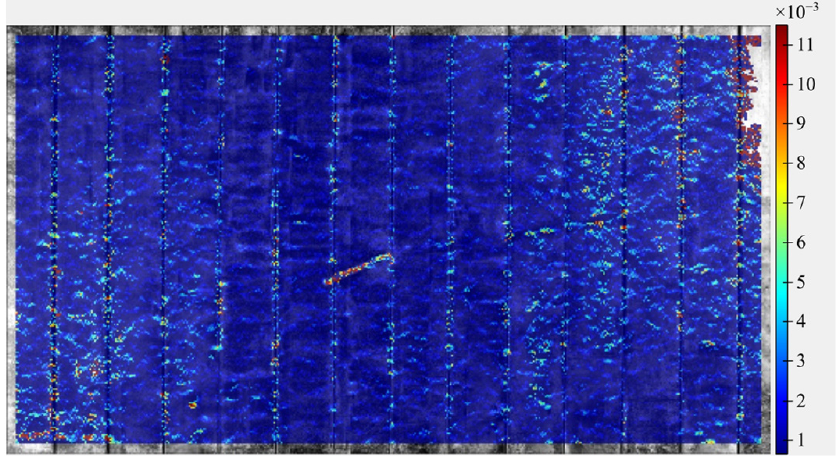
Figure 9. DIC strain plot at the target load (45 tons + 3 × 31 tons).